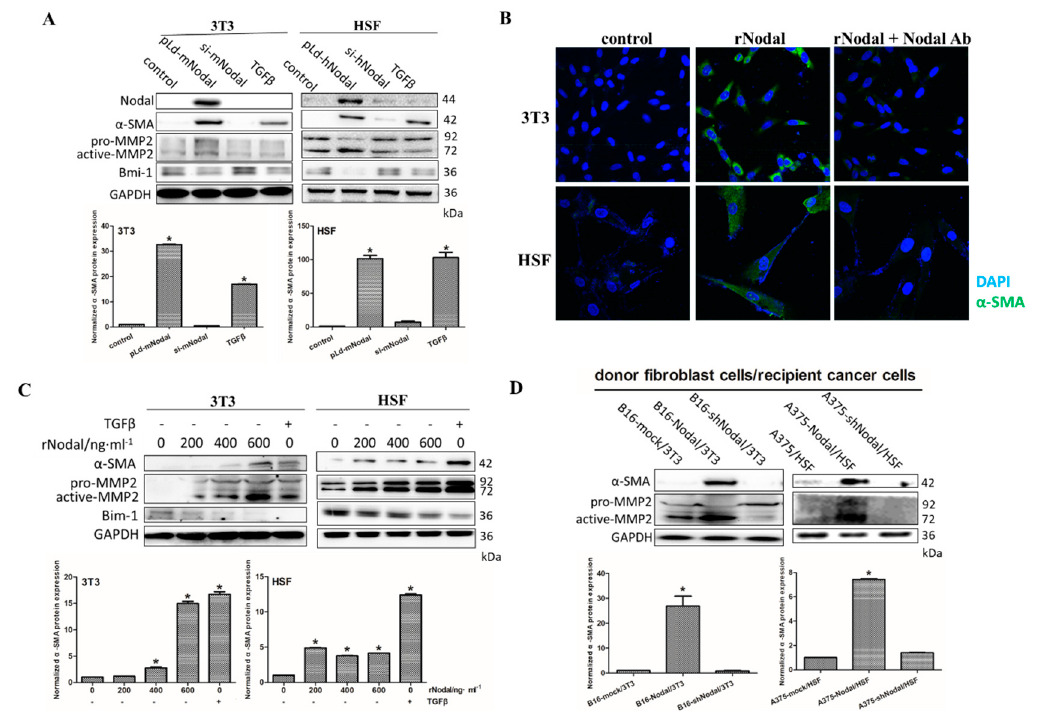
Figure 2. Nodal facilitates the differentiation of fibroblasts to CAFs. ( A ) After transfection with pLd-Nodal or siNodal or the presence of 10 ng/mL transforming growth factor- β (TGF- β ), protein expression of Nodal, α -SMA, MMP2, and Bmi-1 in 3T3 and human skin fibroblasts (HSF) cell lines was measured by western blot (up) and quantitatively analyzed (below). ( B ) α -SMA immunofluorescence staining of 3T3 and HSF cells treated with recombinant Nodal protein or blocked by 10 µ g / mL Nodal antibody (Abcam, Cambridge, MA, USA) are presented. ( C ) The protein expression of α -SMA, MMP2, and Bmi-1 in 3T3 and HSF cells treated with 200, 400, and 600 ng / mL recombinant Nodal protein or TGF- β was detected by western blot (up) and quantitatively analyzed (below). ( D ) α -SMA and MMP2 expression of 3T3 and HSF cells co-cultured with B16, B16-Nodal, B16-shNodal, A375, A375-Nodal, and A375-shNodal were analyzed by western blot (up) and quantitatively analyzed (below). * p < 0.05.